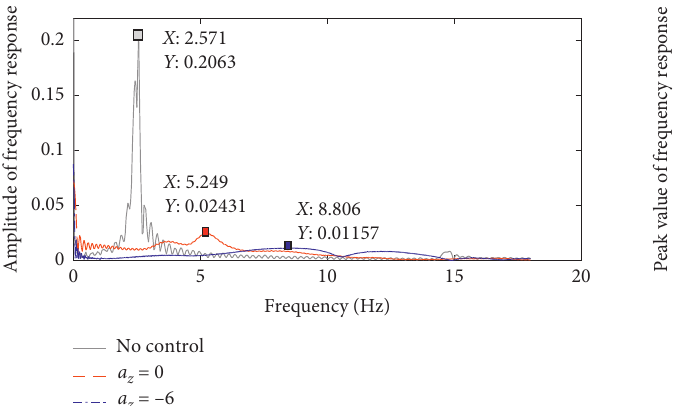
Figure 14: Peak of the amplitude-frequency characteristic curve.